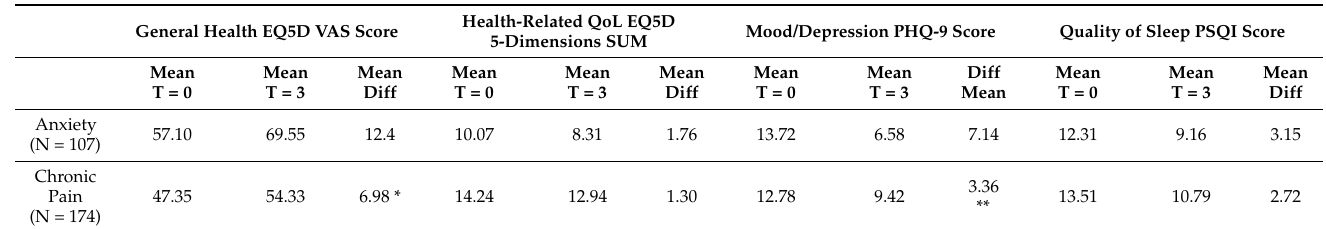
Table 2. Comparative analysis on the influence of the two main participants sub-populations by primary indication, chronic painful conditions, and anxiety-related disorders, over the general PROMS: HRQoL, mood/depression and sleep quality. * p < 0.05; ** p <